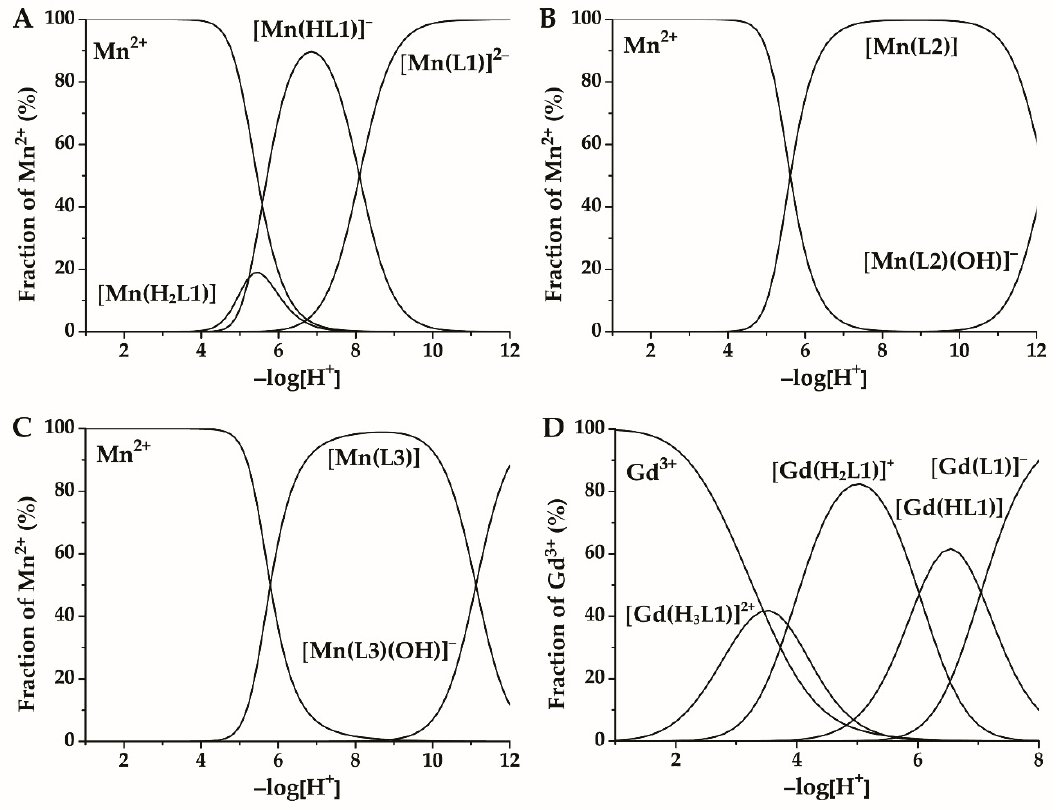
Figure 3. Species distribution diagrams of A : Mn(II)–1,4-H 4 do2p (H 4 L1); B : Mn(II)–1,4-H 2 do2p OEt (H 2 L2); C : Mn(II)–1,4-H 2 Bn 2 do2p H (H 2 L3); and D : Gd(III)–1,4-H 4 do2p (H 4 L1) systems (C M = C L = 5 mM, I = 0.1 M NMe 4 Cl, 25 °C).